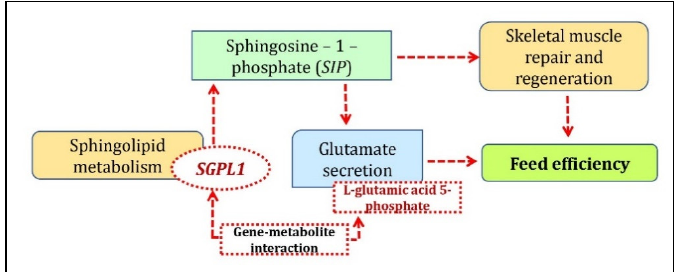
Figure 4. Biological mechanism showing the involvement of SGPL1 -L-glutamic acid 5-phosphate gene-metabolite pair underlying sphingolipid metabolism identified from Duroc correlated/Landrace anti-correlated cluster.